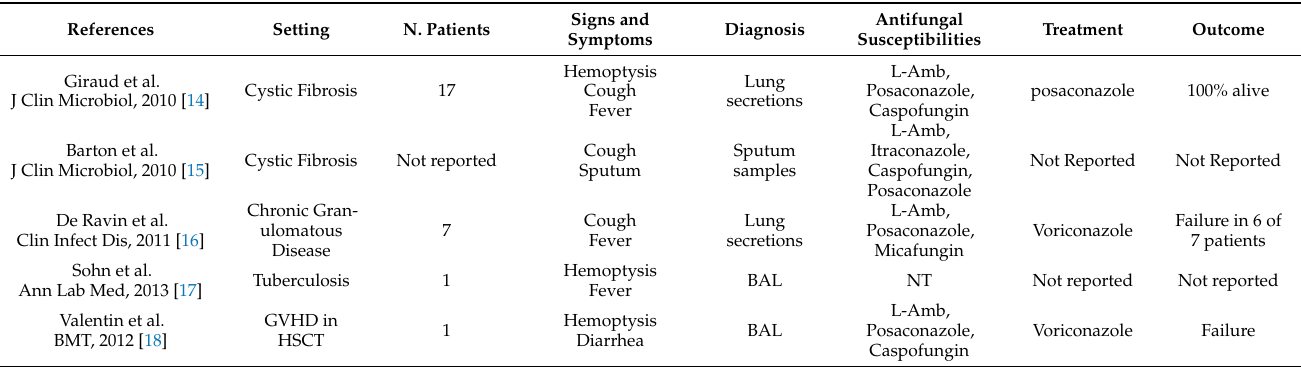
Table 1. Cases of Geosmithia argillacea reported in